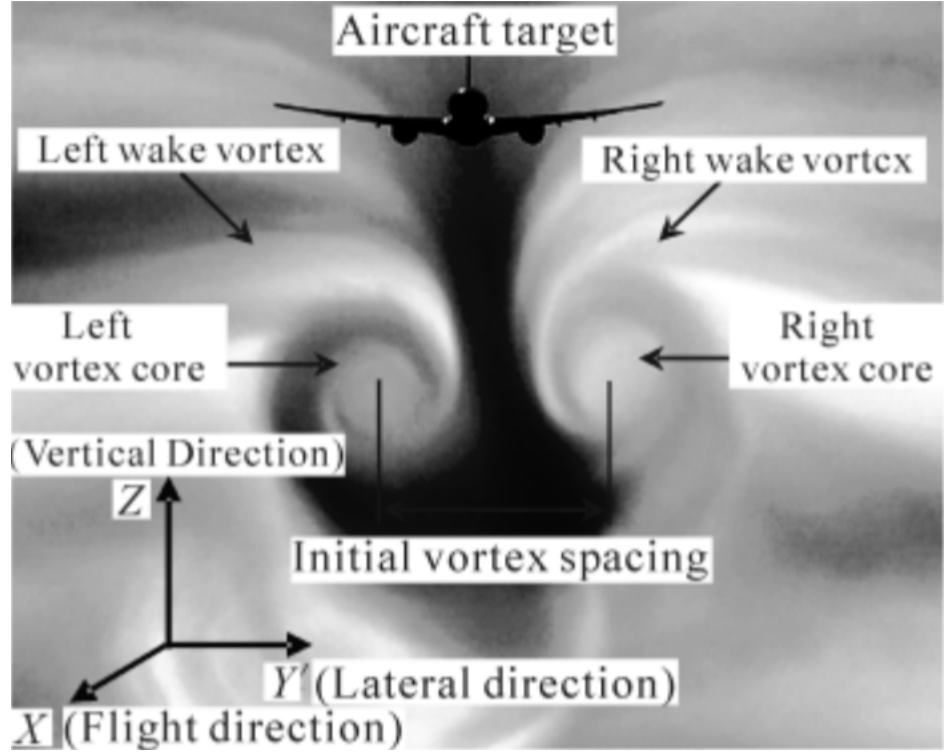
Figure 5. Cross section of wake vortices generated by the lift producing surfaces of an aircraft